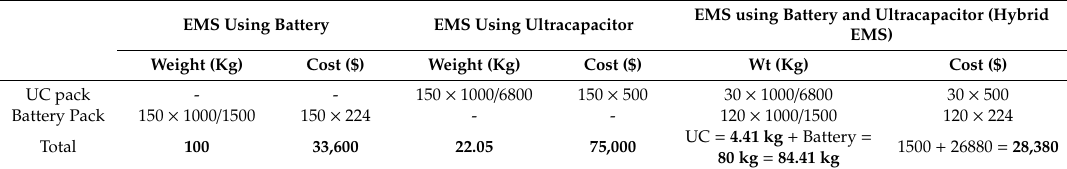
Table 3. Comparative analysis for energy management system.